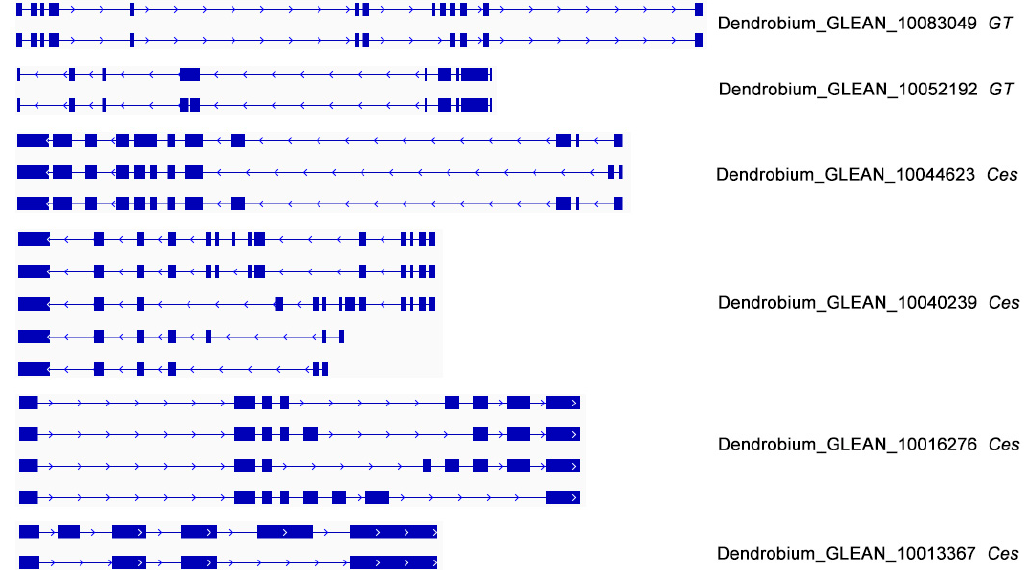
Figure 7. Alternative splicing isoforms of genes involved in polysaccharide biosynthesis encompassed by PacBio long reads. GT : glycosyltransferases gene; Ces : cellulose synthase gene.